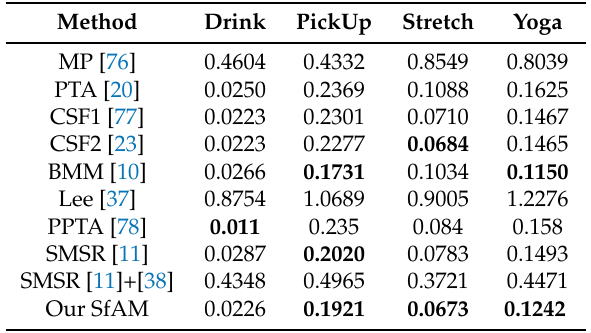
Table 2. The normalized mean 3D error e 3 D of previous NRSfM methods and our SfAM for synthetic sequences